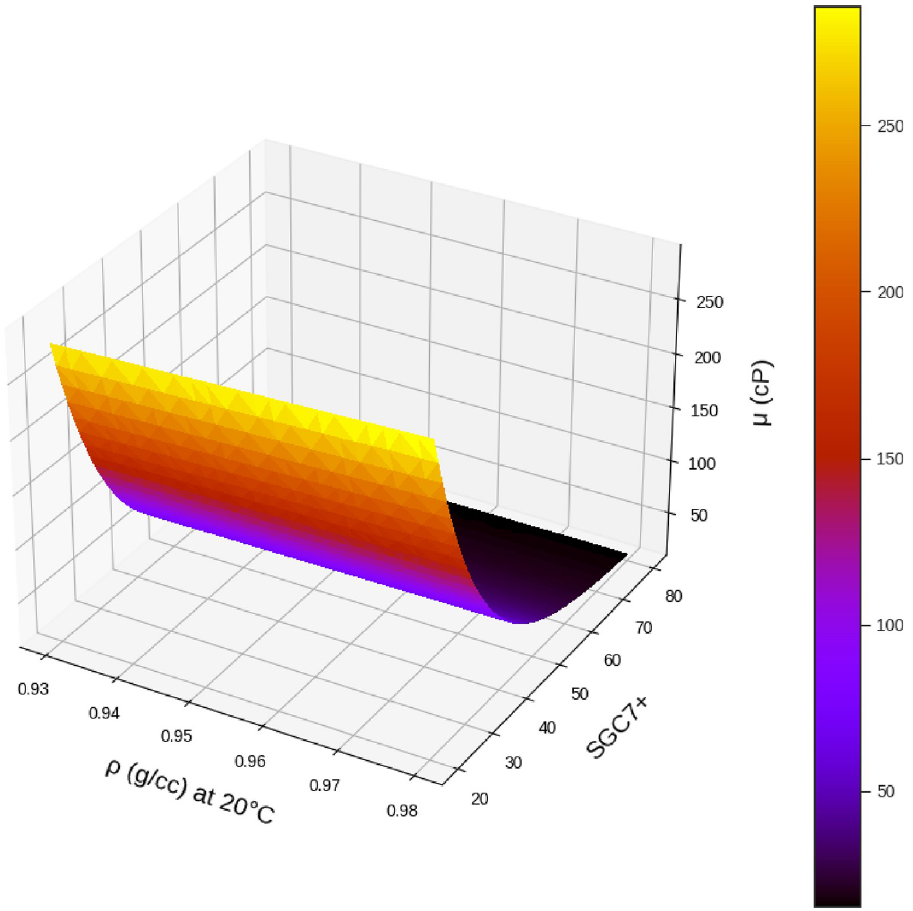
Fig 9. Influence of SGC7+ and ρ (g/cc) on the output. API = 18.6, %C4 = 0.35, %C5 = 1.62, %C6 = 3.21, %C7+ = 94.81, MWC7+ = 338.41, T (˚C) =